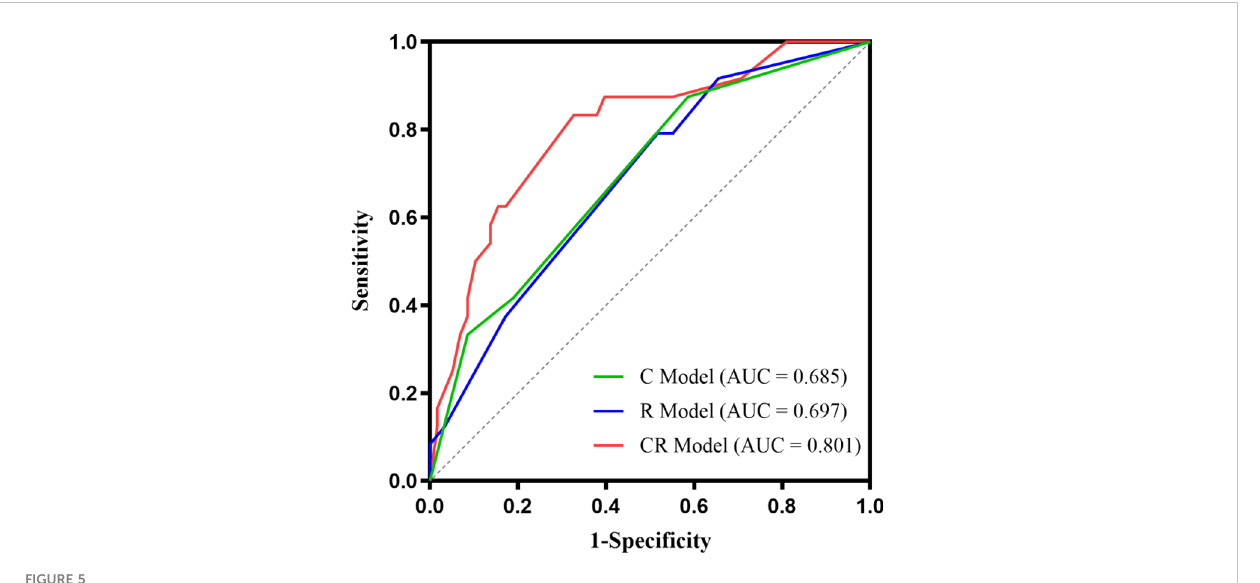
FIGURE 5 The ROC curves of the three models in BCLC 0-A stage